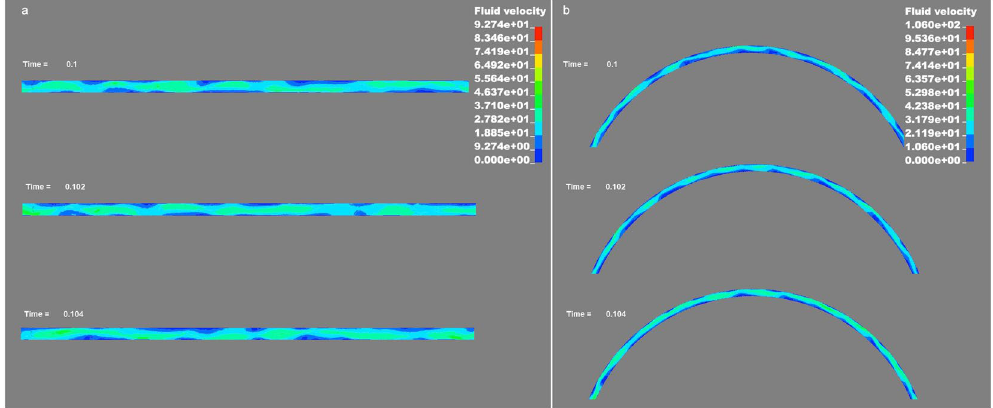
Figure 2. Magnitude of instantaneous fluid velocity at t = 0.100 s, t = 0.102 s and t = 0.104 in ( a ) S1 and ( b )